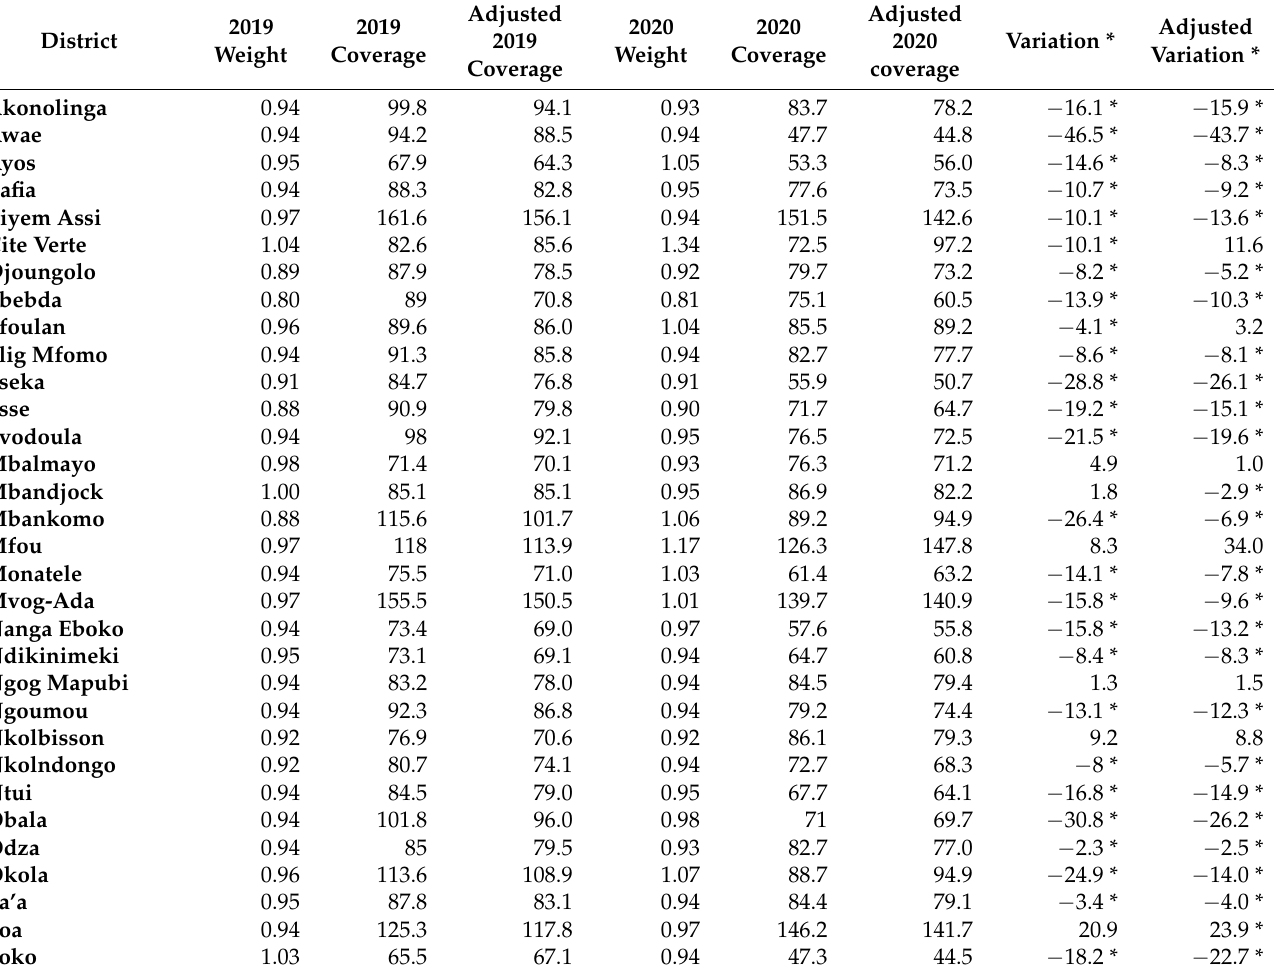
Table 4. DTP-3 coverage variations in the pre-pandemic and pandemic period in the Centre